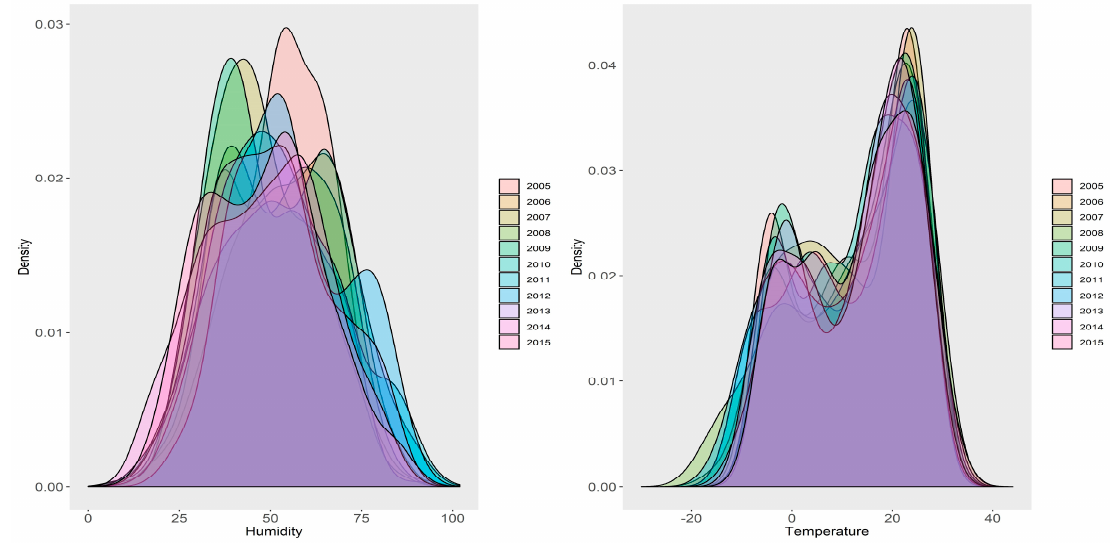
Figure 5. Yearly density distribution plots of ambient mean temperature and relative humidity. Density distribution of different years could be told by different colors. Table 6. Significant levels of meteorological differences among the five datasets.